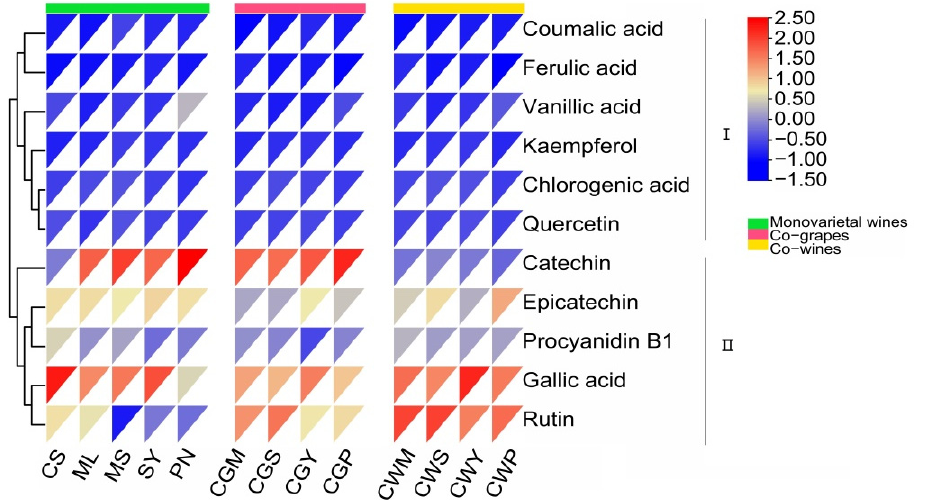
Figure 3. Monomeric phenol content of wine samples (mg/L) from different varieties and blending methods.